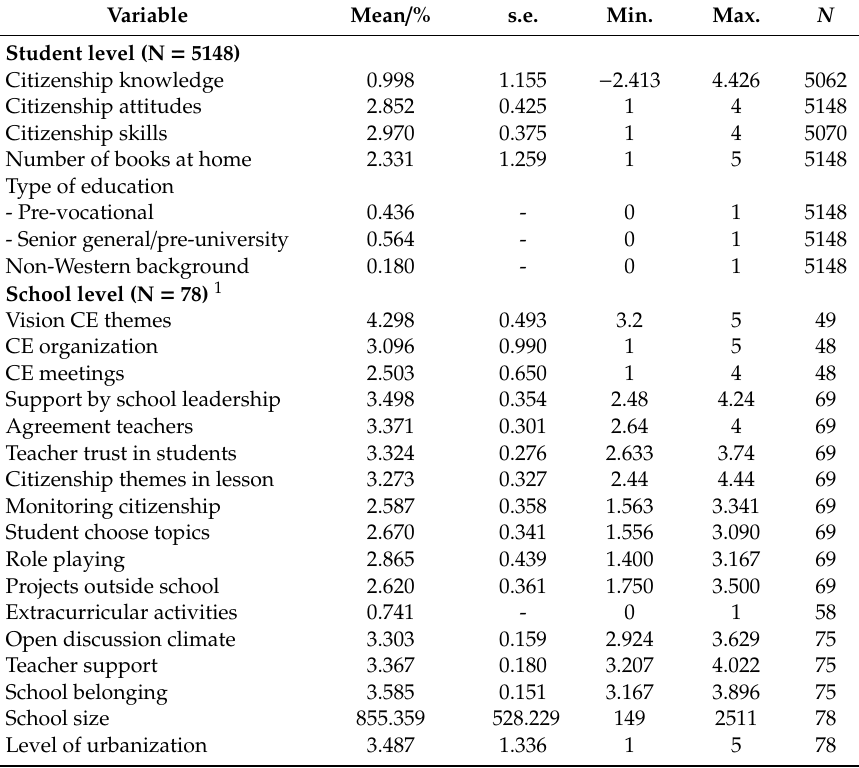
Table 2. Descriptive statistics (N = 78 schools; N = 5148